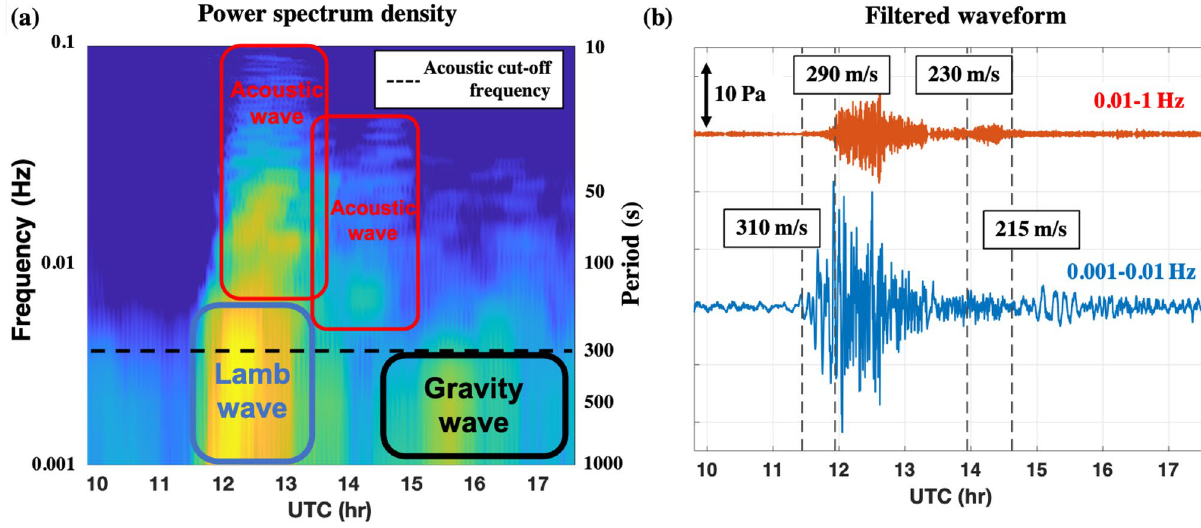
Figure 4. Time series of atmospheric pressure perturbations at Muroto, Kochi (N33.25, E134.18). ( a ) Power spectrum density of atmospheric pressure waves and ( b ) filtered signals in two frequency ranges.